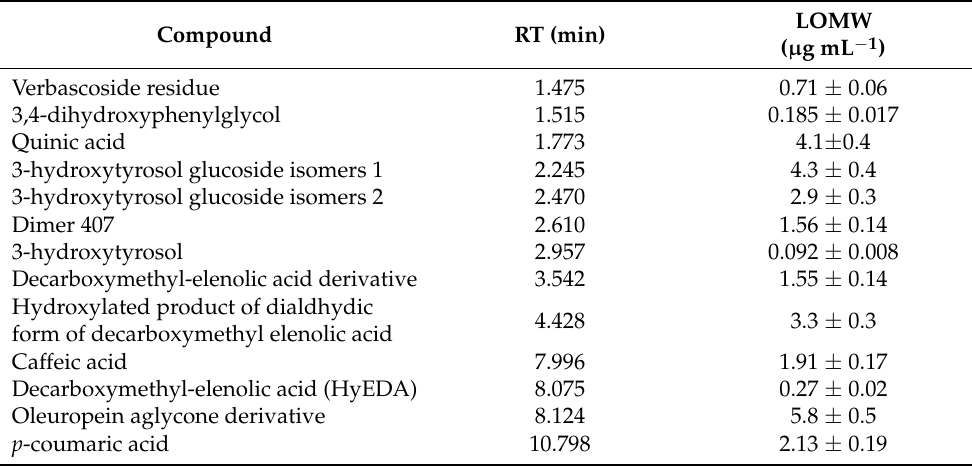
Table 1. Identified polyphenol compound in LOMW (in µ g mL − 1 ). Data represent mean ± RSD